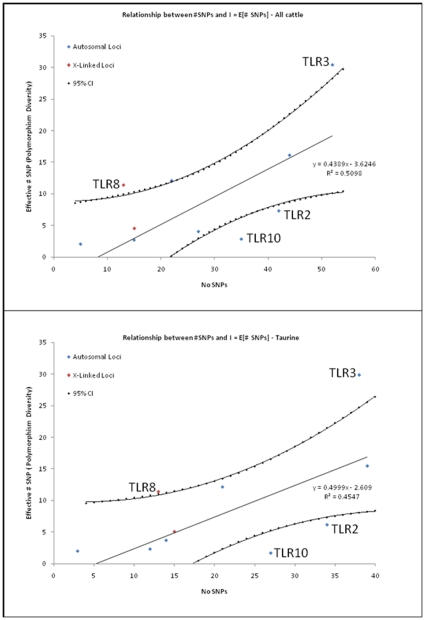
Relationship between the number of validated SNPs and SNP diversity here denoted as the effective number of SNPs across all 10 TLR loci in A) all cattle, and B) taurine cattle.The linear regressions and estimated 95% confidence intervals are shown in each panel.